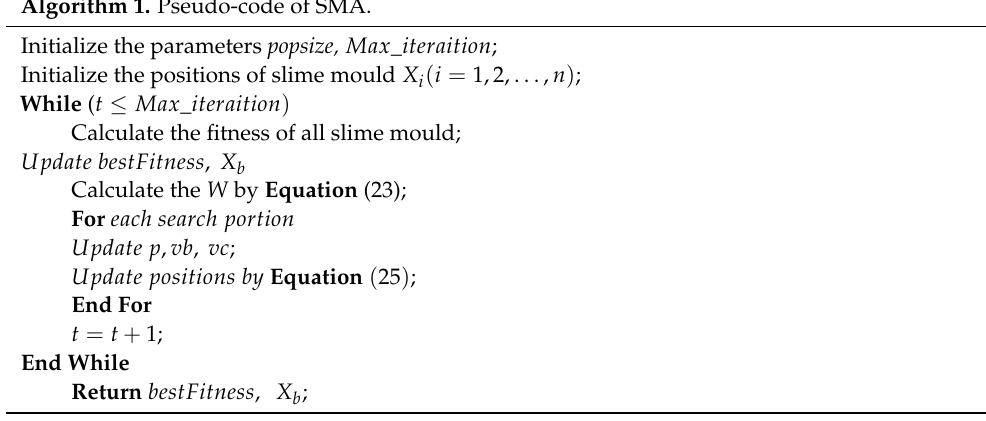
Algorithm 1. Pseudo-code of SMA.